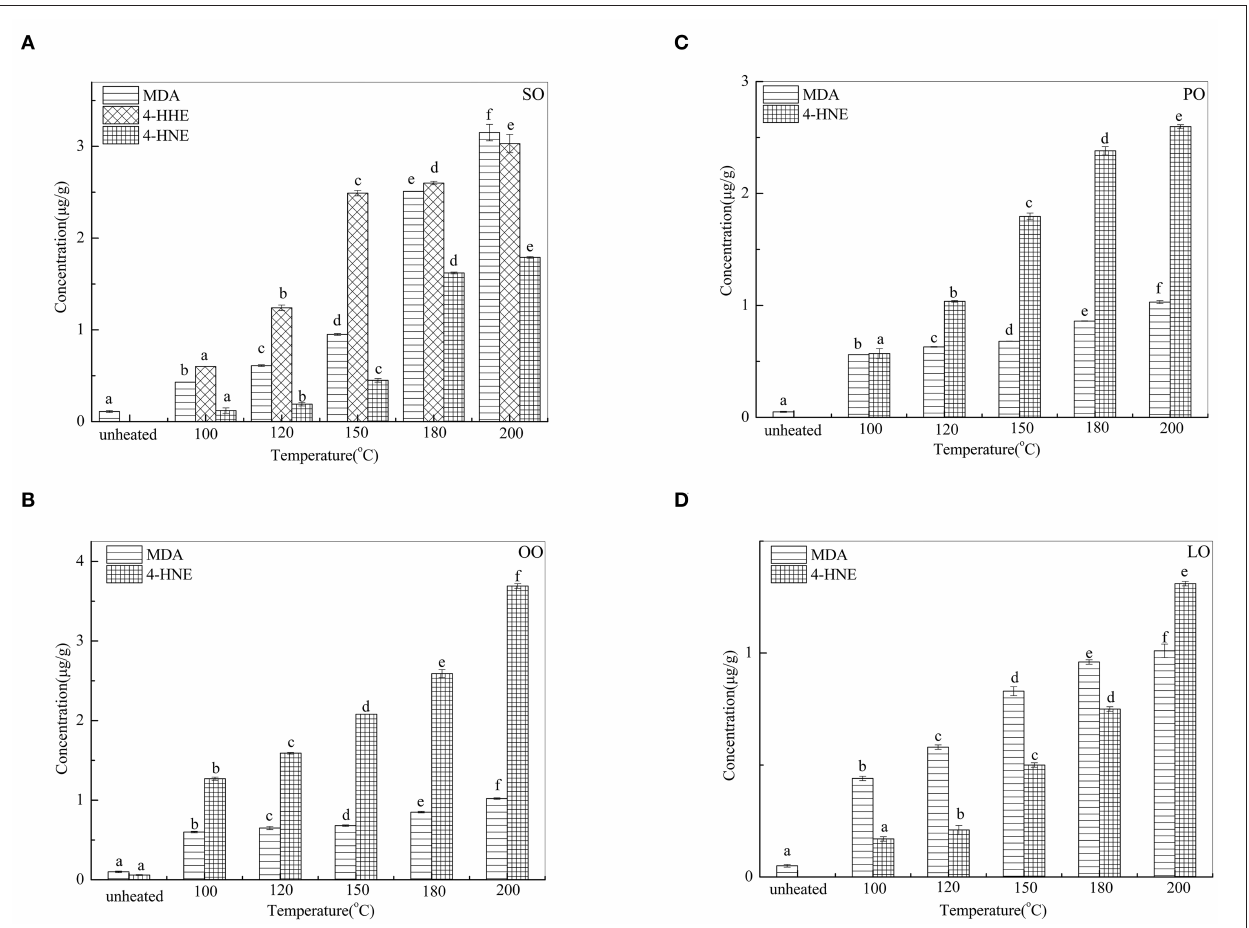
FIGURE 2 | Changes of MDA, 4-HHE, and 4-HNE in SO (A) , PO (B) , OO (C) , and LO (D) at different temperatures. Data were expressed as mean ± SD in triplicates. Different lowercase denotes significant difference ( p < 0.05).